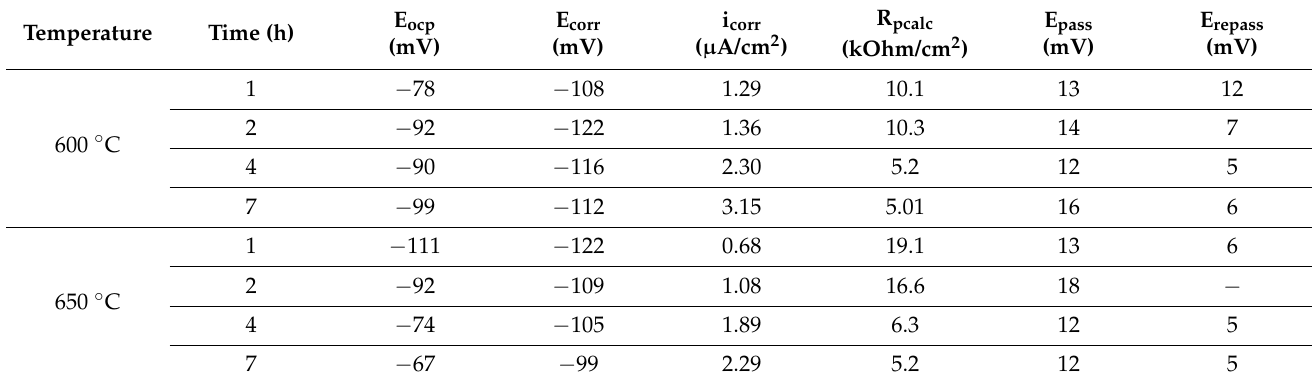
Figure 2. Electrochemical characteristics of the corrosion resistance test of aged samples at 650 °C: ( a ) open circuit potential, ( b ) anodic and cathodic polarization curve, ( c ) cycling potentiodynamic polarization curves with hysteresis loop (cathode and anode curves). Table 2. Results of the corrosion resistance test of samples after aging.